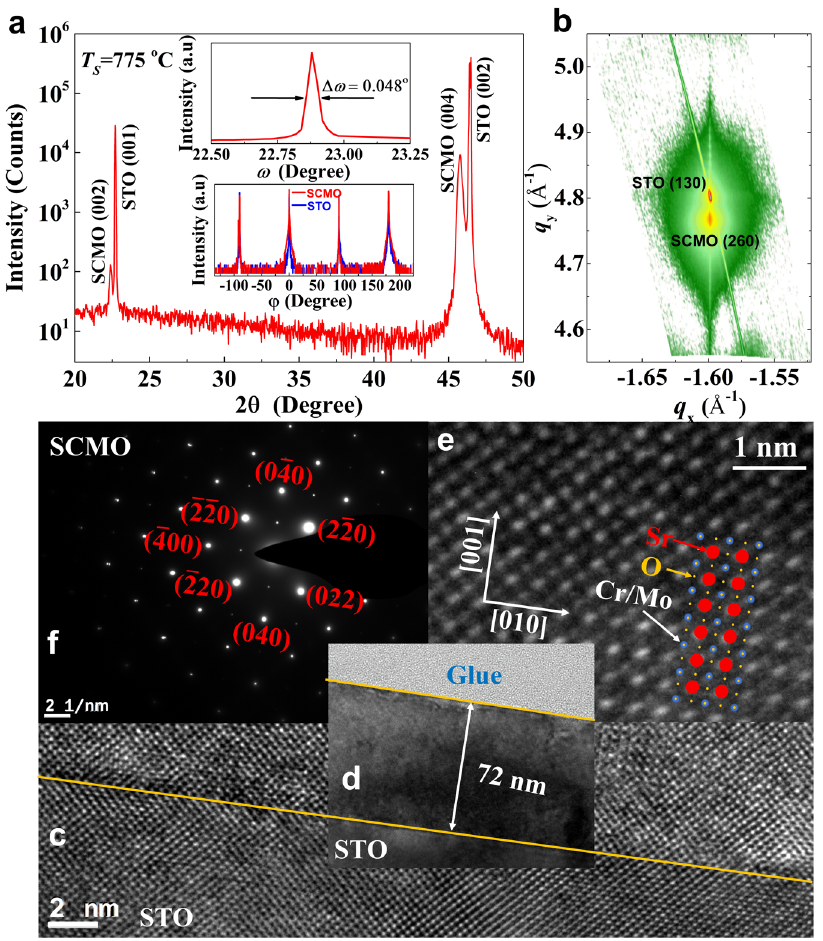
Fig. 1 Crystallographic structure of the SCMO thin fi lm. a XRD patterns of SCMO thin fi lm on STO substrate, sample S 5 . The upper and lower insets demonstrate the rocking curve taken around (004) peak of SCMO and the XRD φ -scan patterns for the fi lm (red curve) and substrate (blue curve), respectively. b X-ray reciprocal space mapping of S 5 in a certain q range, in which, the relatively smaller peak with stronger intensity is STO ’ s (130) peak. c – f HRTEM images of sample S 5 : panel ( d ) demonstrates that the SCMO thin fi lm thickness is ~72 nm, with an atomically smooth surface and interface indicated by the yellow line. Panel c and e show the atomically resolved images near STO-SCMO boundary, which witnesses the nearly perfect crystallization of SCMO thin fi lm. The SAED pattern of SCMO thin fi lm is displayed in panel f , in space which we indexed several bright points based on F m 3 m